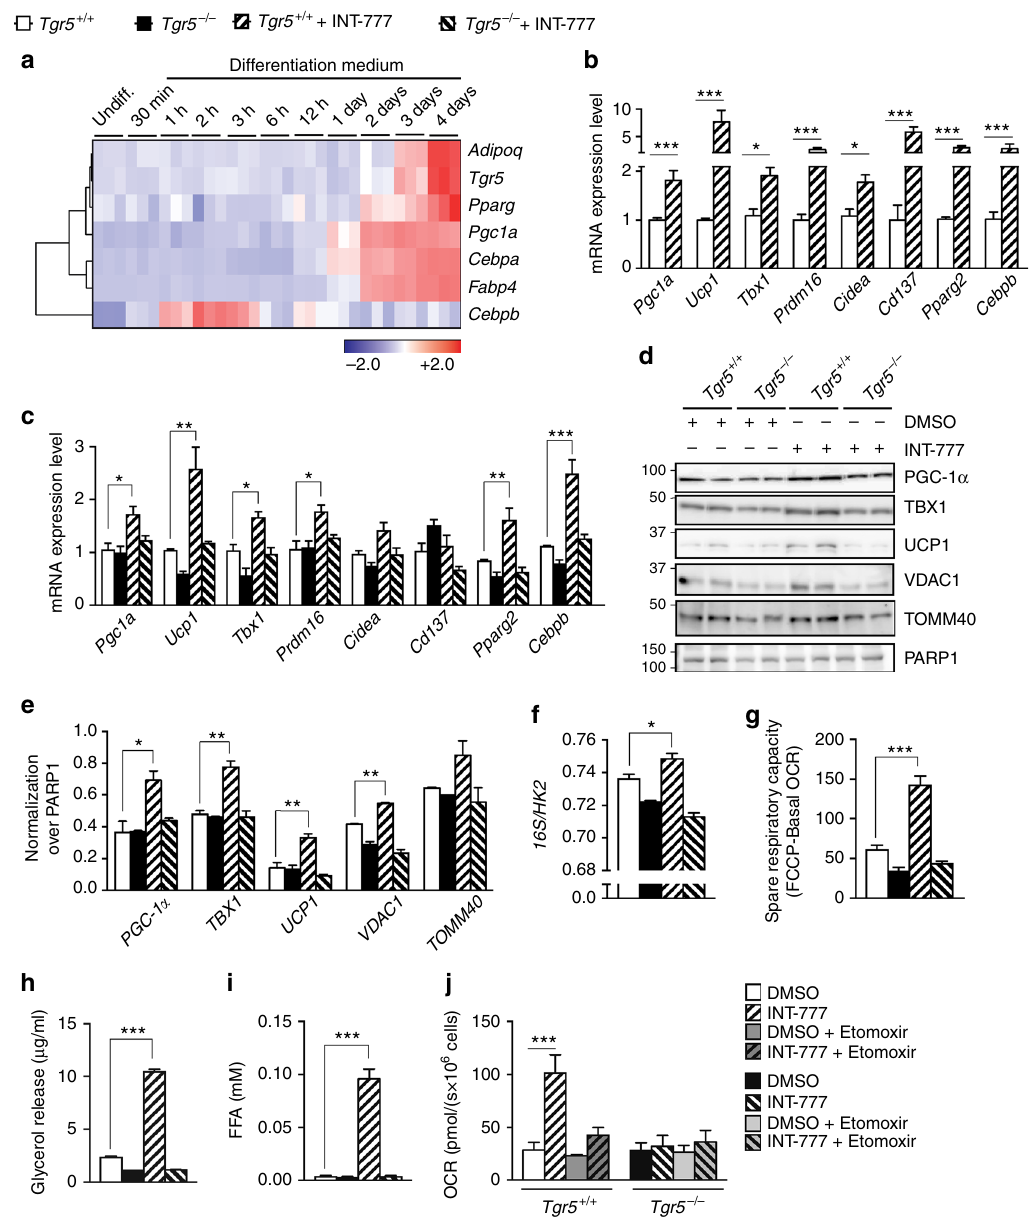
Fig. 5 TGR5 activation promotes beige adipocyte differentiation in vitro. a Heat map showing the expression of Tgr5 and adipocyte and beiging markers from human bone marrow-derived mesenchymal stem cells induced for adipogenic differentiation (GEO Accession number GSE80614) 32 . Colour key represents row z -score. b mRNA levels of beige remodelling markers Pgc1a , Ucp1 , Tbx1 , Prdm16 , Cidea , Cd137 , Pparg2 and Cebpb assessed in the human pre- adipocyte cell line, Simpson Golabi Behmel Syndrome (SGBS). SGBS cells were differentiated in presence or absence of the TGR5 agonist INT-777. n = 6. c mRNA levels of genes described in b in adipocytes differentiated from the stromal vascular fraction (SVF) of TGR5 wild-type ( Tgr5 + / + ) and germline TGR5 knock-out ( Tgr5 − / − ) mice. SVF cells were differentiated for 7 days in presence or absence of the TGR5 agonist INT-777. n = 6. d Representative ( n = 6 per group) western blot of PGC-1 α , mitochondrial markers (VDAC1 and TOMM40) and beiging markers TBX1 and UCP1 from the cells described in c . PARP1 was used as loading control. e Quantitative densitometry of the western blots showed in d . f Quanti fi cation of mitochondrial (16S) vs. nuclear (HK2) DNA ratio from the cells described in c . g Spare respiratory capacity of the cells described in c , calculated as the difference between maximal (FCCP) and basal oxygen consumption rate (OCR). h , i Glycerol ( h ) and fatty acid ( i ) release from the cells described in c after 1 h stimulation with the TGR5 agonist INT-777 or vehicle (DMSO). j Basal oxygen consumption rate (OCR) of cells described in c after 3 h pre-incubation with etomoxir and stimulation with the TGR5 agonist INT-777 or vehicle (DMSO). Results represent mean ± SEM. * P ≤ 0.05, ** P ≤ 0.01 and *** P ≤ 0.001 vs. Tgr5 + / + cells by one-way ANOVA followed by Bonferroni post hoc test ( c , e – j ) or Student ’ s t test ( b ). Uncropped western blots are provided in Supplementary Fig. 13A – C and Supplementary Fig. fi ssion is the GTPase dynamin-1-like protein (DRP1) that can be 777 in Tgr5 +/+ adipocytes (Fig. 6e; Supplementary Fig. 6A). activated through phosphorylation by ERK at Serine 616 in However, the extracellular signal-regulated kinase (ERK) signal- mouse and human cells 37,38 . Conversely, phosphorylation of ling pathway was also robustly activated (Fig. 6e; Supplementary DRP1 at Serine 637 by PKA inactivates the protein leading to Fig. 6A). One of the main proteins implicated in mitochondrial